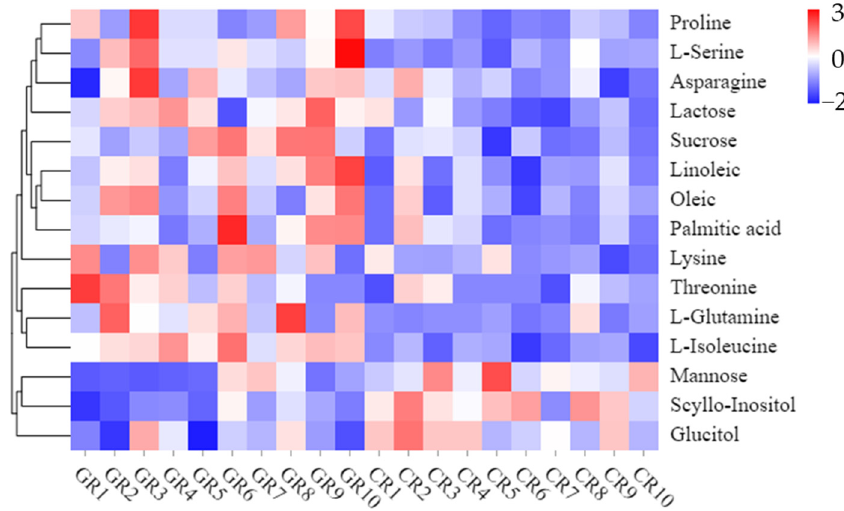
Figure 3. Heatmap of fifteen key metabolites differentially expressed between green and conventional rice. Note: GR = green rice, CR = conventional rice. The more intense red color indicates a higher level of metabolite expression; the more intense blue color indicates a lower level of metabolite expression.